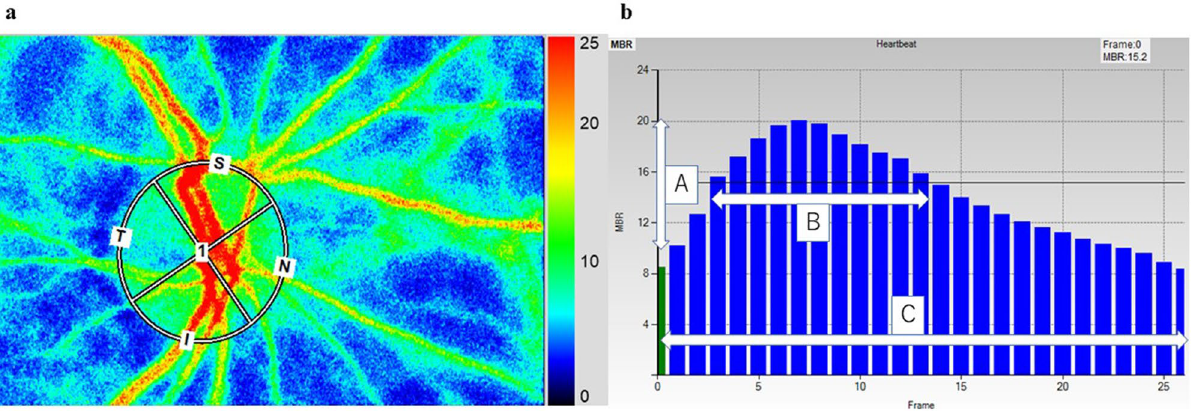
Figure 5. Methods of determining the pulse-wave velocity in the optic nerve head circulation by laser speckle flowgraphy (LSFG). The left panel shows a circle defining the area for measurements in the optic disc area. The right panel shows the normalization of one pulse. A = maximum mean blur rate (MBR)—minimum MBR. B = number of frames spent at one-half the value of A. C = number of frames spent at normalized one